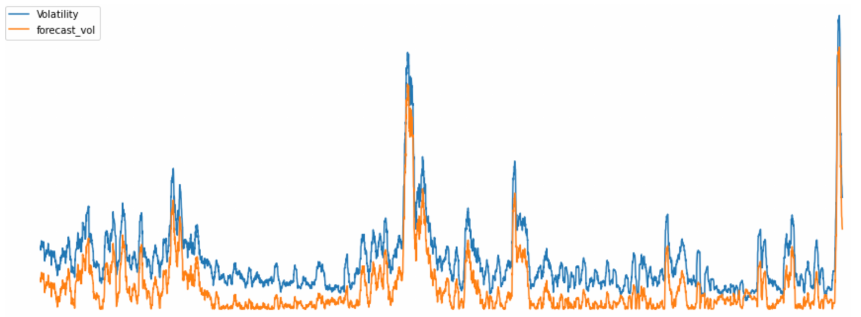
Figure 1. Volatility output from the GARCH(1,1) process for the period from January 2000 to January 2020. The parameter α 0 is equal to 0.418; α 1 is equal to 1.000; and β is equal to 3.606 × 10 − 11 (source: authors’ calculations).